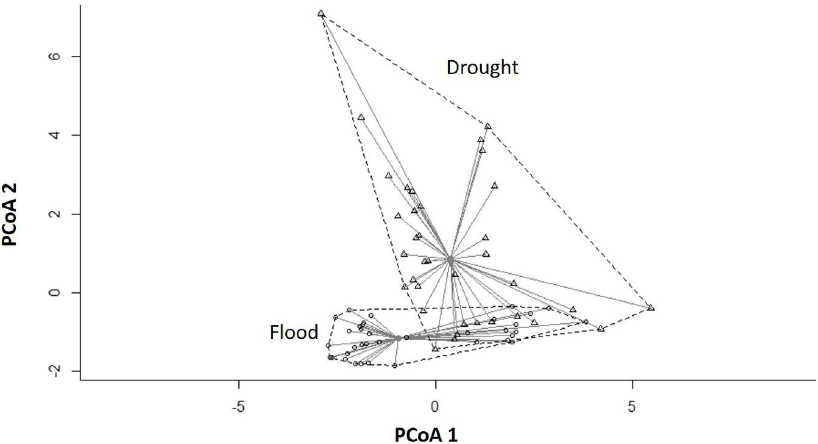
Figure 3. Mean distances to centroid based on differences of abiotic variables between flood and drought periods. Each point on the graph represents the dissimilarity of abiotic variables of an individual lake sampled from different hydrological periods. Triangles represent drought period and circles represent flood period.